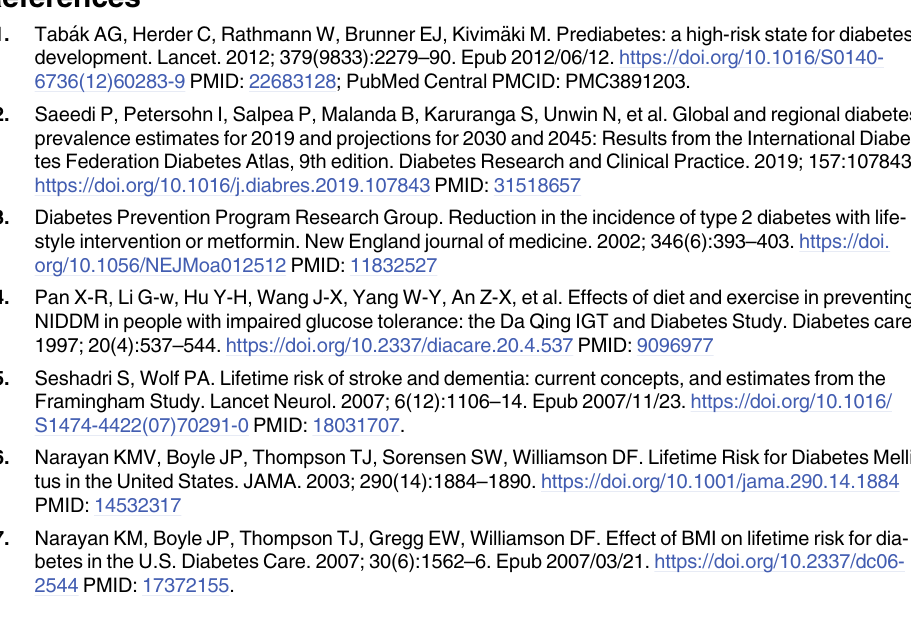
S7 Table. Expected remaining lifetime risks of progression from prediabetes and normo- glycemia to diabetes, expressed as percentages, at age 45 years estimated in CHARLS sam- ple, HKDSD sample, and HKDSD sample with mortality rates substituted. CHARLS, China Health and Retirement Longitudinal Survey; HKDSD, Hong Kong Diabetes Surveil- lance